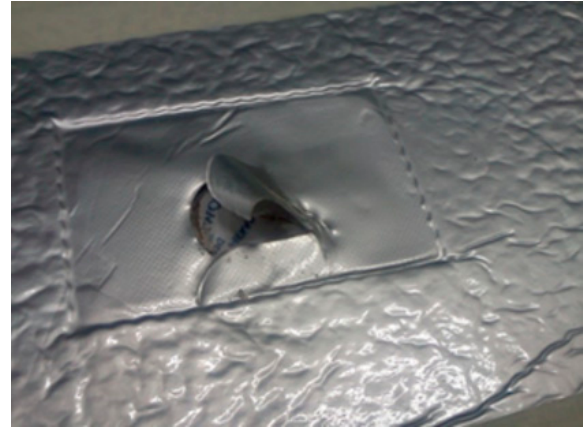
Figure 7. Breakage occurrence during shape machining of vacuum insulator.